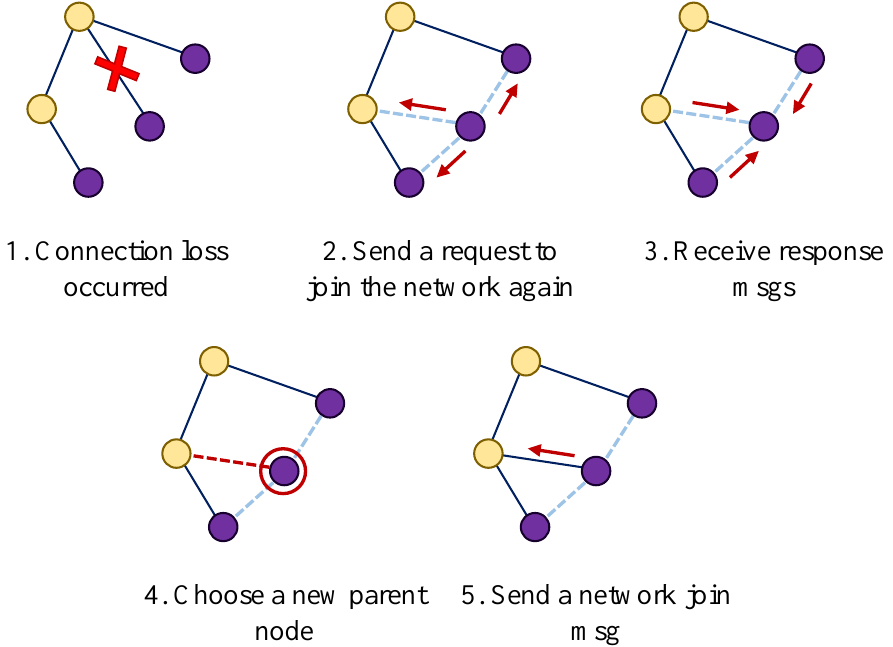
Figure 8. Sequence of reconfiguration with an updated resource provider network by finding a new parent